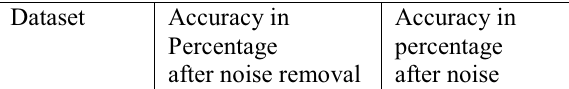
Table 8: Results obtained from without Noise without feature selection and with Feature Selection